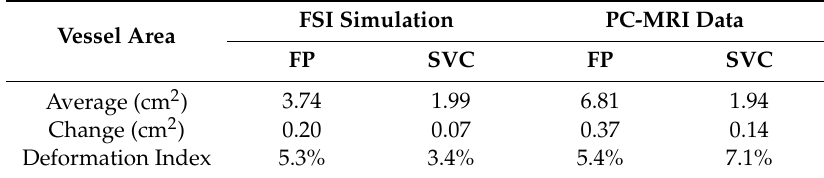
Table 3. Comparison of vessel areas between fluid-structure interaction (FSI) simulation and in vivo phase-contrast MRI (PC-MRI) data. FP: Fontan pathway, SVC: superior vena cava.